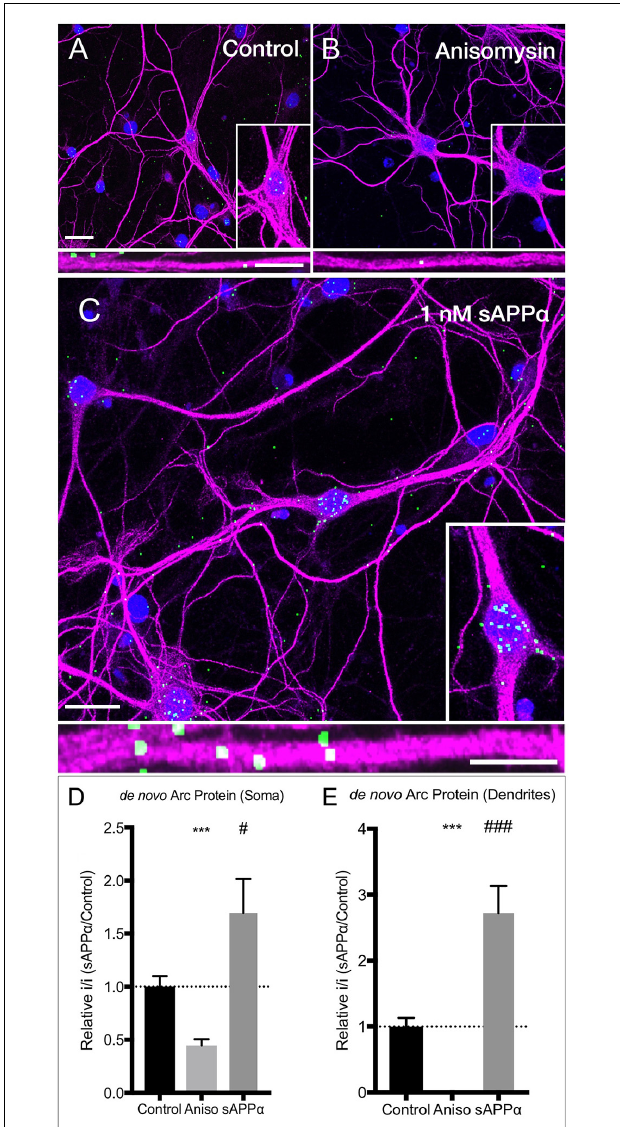
FIGURE 3 | sAPP α increases somatic and dendritic expression of de novo Arc protein. Representative images show neurons (MAP2 positive neurons; magenta) expressing FUNCAT-PLA signal (green puncta) representing newly synthesized Arc protein in (A) no-drug control cells, (B) anisomycin-treated, and (C) sAPP α -treated (1 nM, 2 h) primary hippocampal cultures. Nuclei are stained blue (DAPI). The relative integrated intensity of (D) somatic and (E) dendritic signal from treatment groups is expressed as drug/average of control and presented as mean ± SEM ( n = 25–34 cells from three independent experiments). Co-incubation of AHA with anisomycin inhibited Arc protein synthesis. Incubation with sAPP α significantly increased the expression of de novo synthesized Arc protein in the somata and dendrites. Images show whole cell (scale bar = 50 µ m), and magnified somatic (inset, bottom right) and dendritic (50 µ m; lower panels; scale bar = 10 µ m). Outliers were removed from each experiment prior to amalgamation using Grubb’s tests, and normality was detected by D’Agostino and Pearson omnibus normality tests. Significance was calculated on data expressed relative to control by use of one sample t -tests; hashes (#) indicate significance between control and sAPP α -treated, asterisks ( ∗ ) indicate significance between control and anisomycin treated, # p = 0.038, ∗∗∗ / ### p ≤